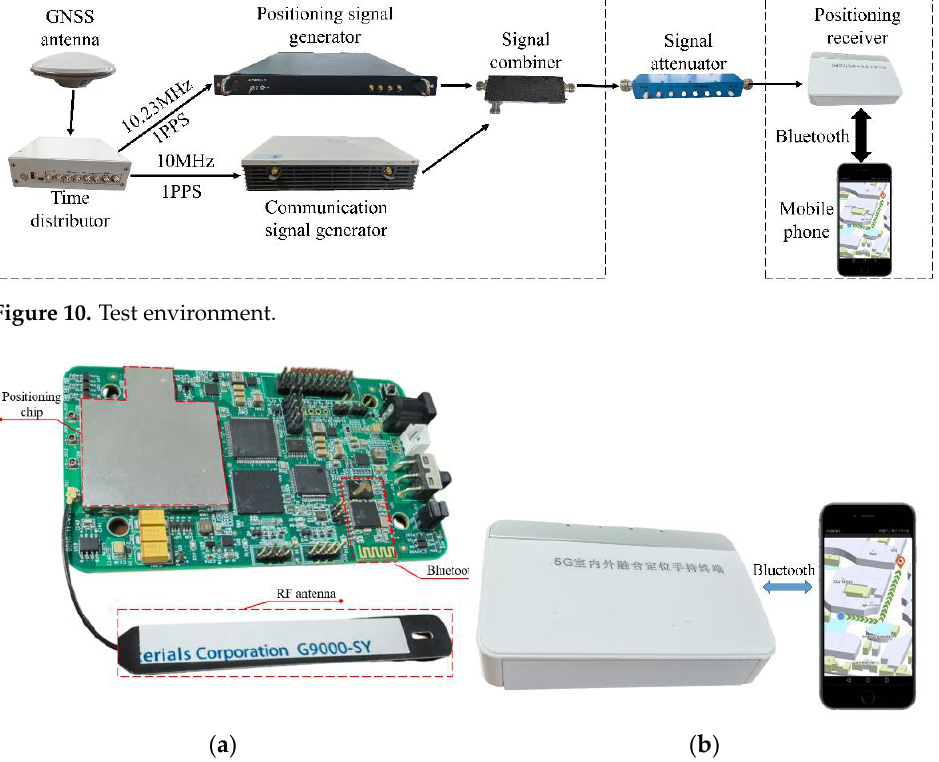
Figure 11. CPIS receiver. ( a ) is the internal structure of the CPIS receiver and ( b ) is the data transmission protocol between receiver and mobile phone. Table 2. Tracking sensitivity of three algorithms under different